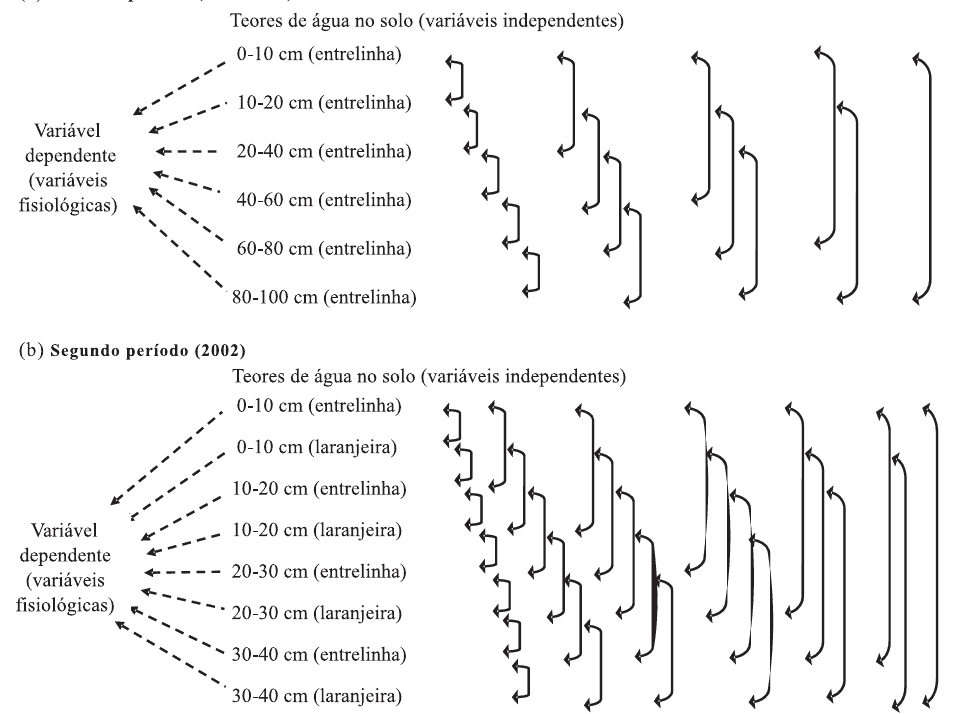
Figura 3. Esquema causal da análise de trilha para o primeiro e segundo período de avaliação entre a variável dependente (taxa de fotossíntese, condutância estomática e potencial da água nas folhas das laranjeiras) e a variável independente (teor de água no solo para as respectivas camadas de solo) nas posições de amostragem de solo centro da entrelinha (entrelinha) e sob limite externo da projeção da copa das laranjeiras (laranjeira), para o primeiro (a) e segundo período de avaliação (b). As linhas pontilhadas indicam o efeito direto do teor de água no solo sobre a variável dependente da análise de